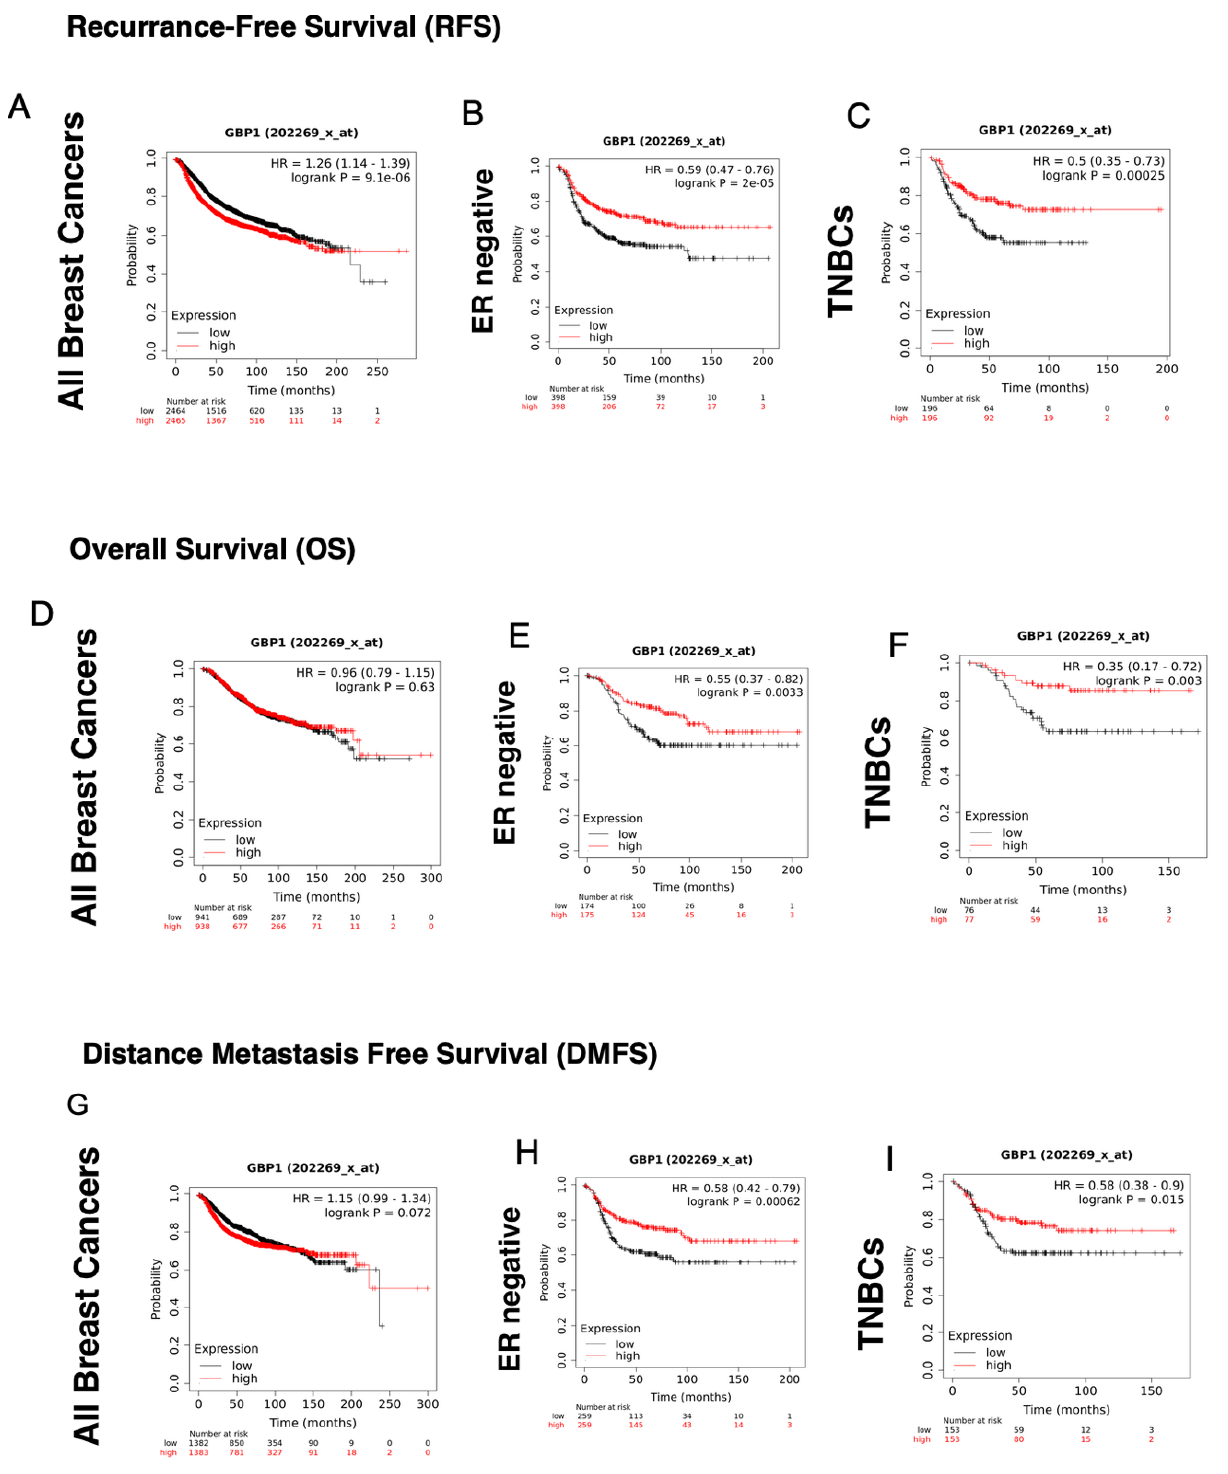
Figure 1. High levels of GBP-1 correlate with better recurrence-free (RFS), overall survival (OS), and distance metastasis-free survival (DMFS) in human ER- and TNBC breast cancers. Km plots were performed for RFS for those tumors with high versus low levels of GBP-1 expression for ( A ) all breast cancers, ( B ) ER- breast cancers, and ( C ) TNBCs. Km plots were performed for OS of tumors with high versus low GBP-1 expression for ( D ) all breast cancers, ( E ) ER- breast cancers, and ( F ) TNBCs. Km plots were performed for DMFS for those tumors with high versus low GBP-1 expression for ( G) all breast cancers, ( H ) ER- breast cancers, and ( I ) TNBCs.